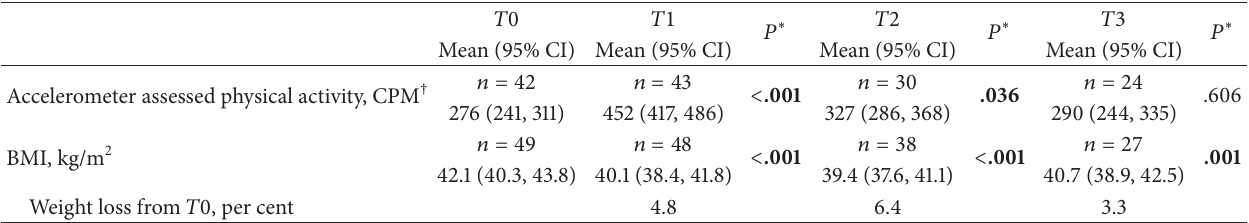
Table 3: Mixed-effect model estimates: physical activity and BMI during the two-year lifestyle intervention for severely obese adults.